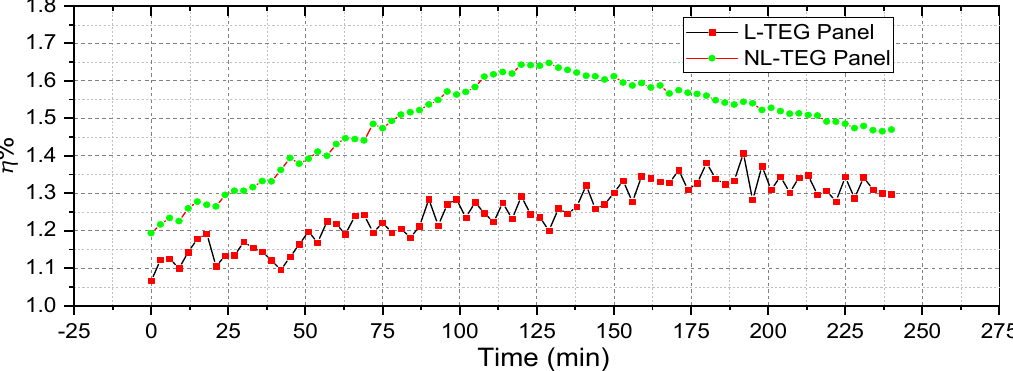
Figure 12. Efficiency for L-TEG and NL-TEG systems.